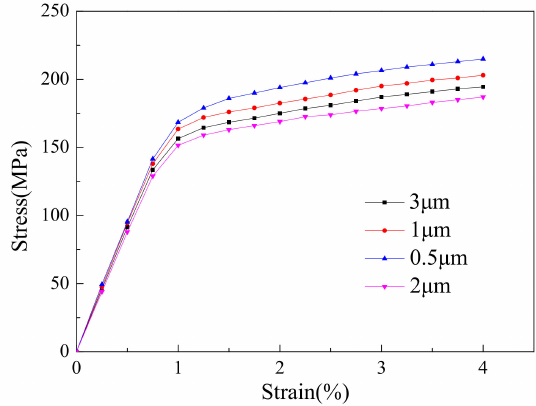
Figure 7. Stress-strain curves of GRANs with di ff erent pore sizes by finite element